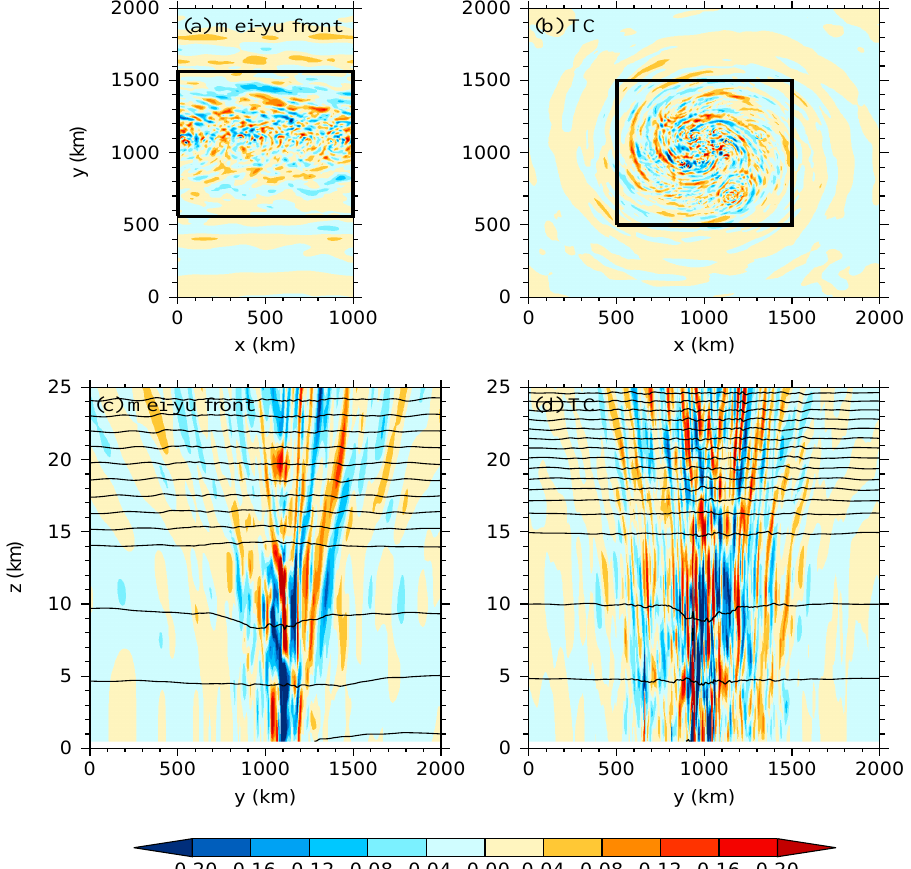
Figure 2. Simulated ( a , b ) horizontal cross sections of vertical velocity (shaded; m s − 1 ) at z = 17 km, ( c , d ) vertical cross sections of vertical velocity (shaded; m s − 1 ) and potential temperature (contours every 20 K) along ( c ) x = 500 km and ( d ) x = 1000 km. The left panels are for the mei-yu front at t = 26 h and the right panels are for the TC at t = 104 h. Boxes in the top panels indicate the wave analysis